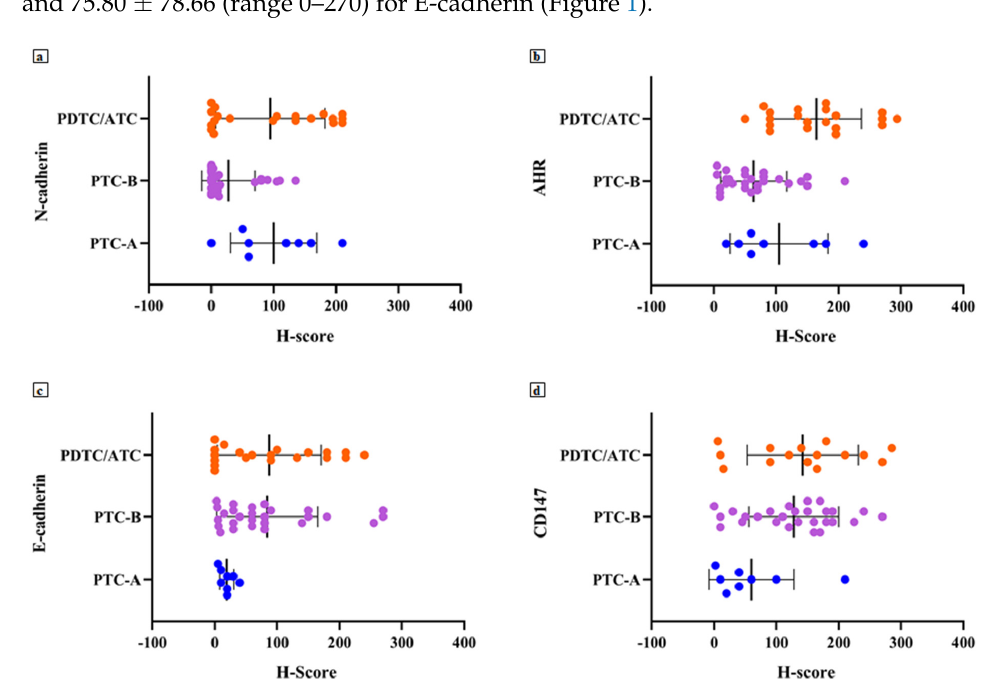
Figure 1. Scatter plots of H-score distribution for N-cadherin ( a ), AhR ( b ), E-cadherin ( c ) and CD147 ( d ) according to tumour groups analysed. Regarding N-cadherin expression, 30 cases (55%) belonged to the low expression class for this protein; 7 (87%) PTC-A and 11 (55%) PDTC/ATC showed high N-cadherin expression. Therefore, the higher the tumour aggressiveness, the higher the N-cadherin expression ( p = 0.005; Table 3, Figure 2). Table 3. N-cadherin, AhR and CD147 expression among tumour groups. Histotype